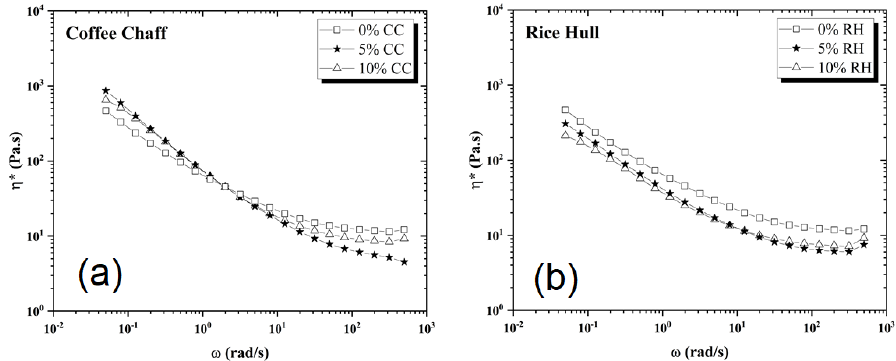
Figure 11. Complex viscosity plots of blends containing ( a ) coffee chaff and ( b ) rice hull at 270 °C.